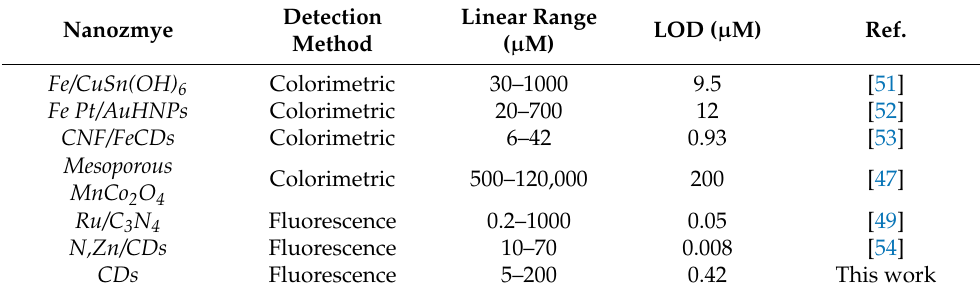
Table 1. Comparison between performance of different nanozymes for H 2 O 2 detection.